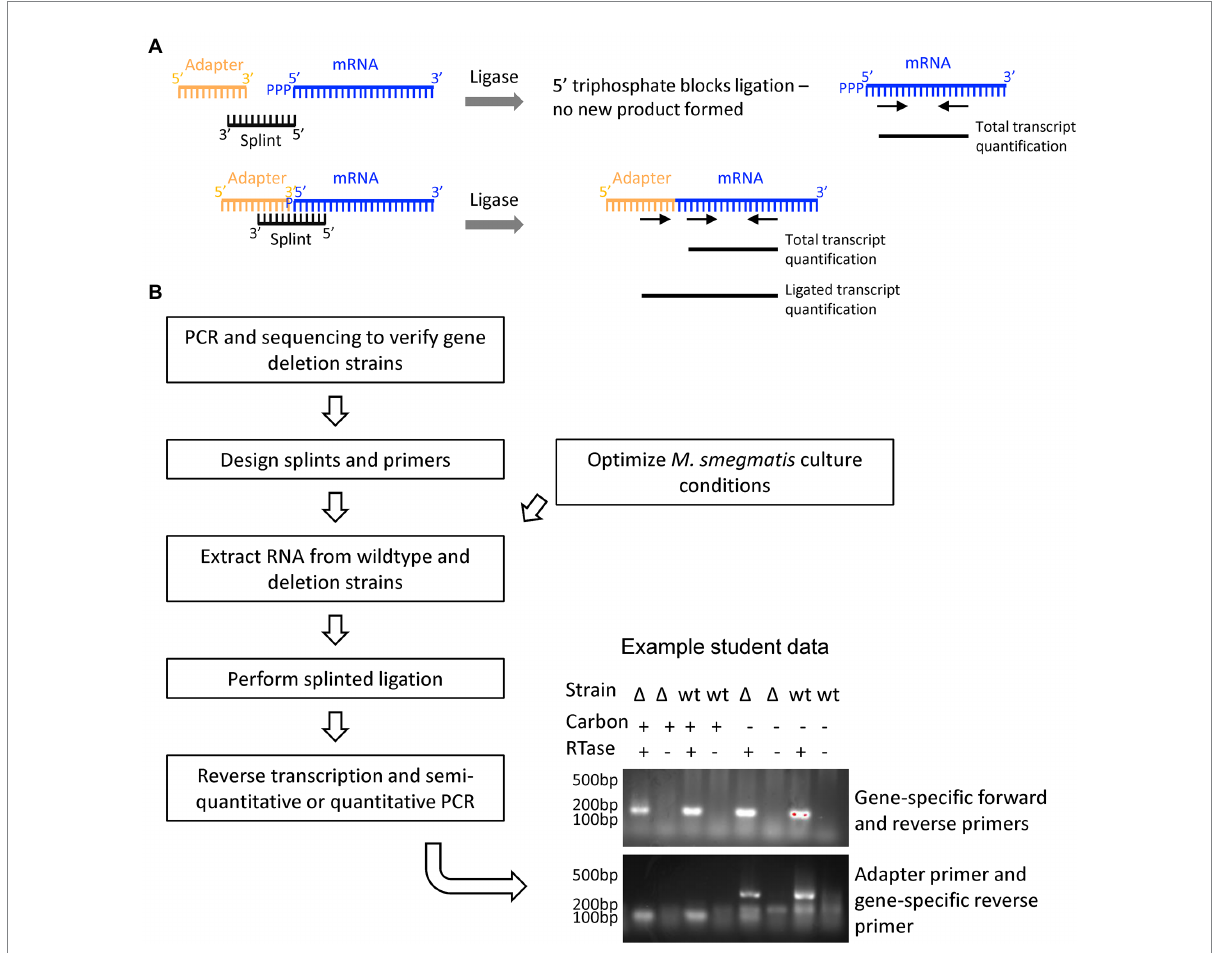
FIGURE 6 Research thrust 3: Assessing mRNA 5 ′ end cap state by splinted ligation. (A) The relative proportion of monophosphorylated mRNA 5 ′ ends was assessed by measuring the efficiency of ligation to an adaptor, which is dependent upon the presence of a 5 ′ monophosphate. mRNAs with 5 ′ triphosphates or other 5 ′ end chemistries are not ligatable. Primers that anneal internally within the transcript were used to quantify total transcript, and an adapter primer paired with and internal primer were used to quantify ligated transcript. (B) Student workflow for confirming the deletion of putative mRNA 5 ′ -end acting genes in M. smegmatis strains obtained from a large collection (Judd et al., 2021), designing splints and primers to assess the 5 ′ end chemistry of putative target transcripts, optimizing standard and carbon starvation culture conditions, extracting RNA,